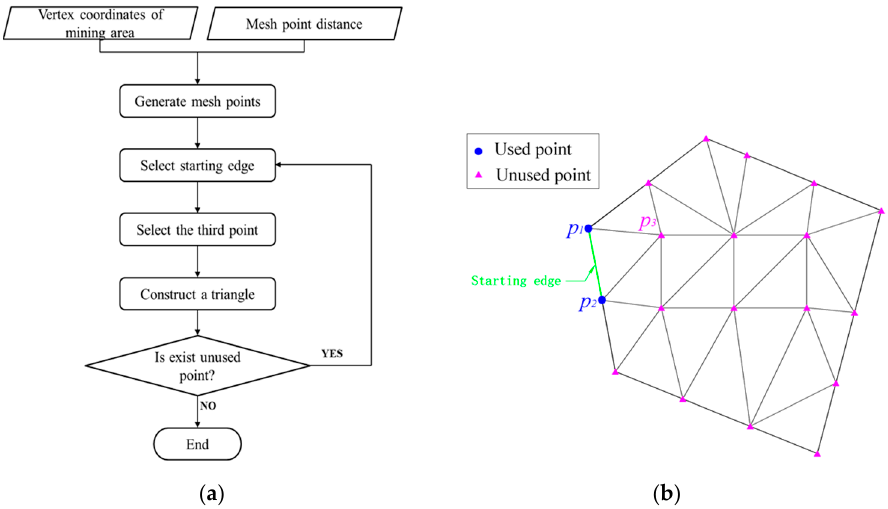
Figure 2. ( a ) Flowchart of DTM-based segmentation algorithm of irregularly shaped mining area. ( b ) Example of Delaunay triangulations generated by DTM.